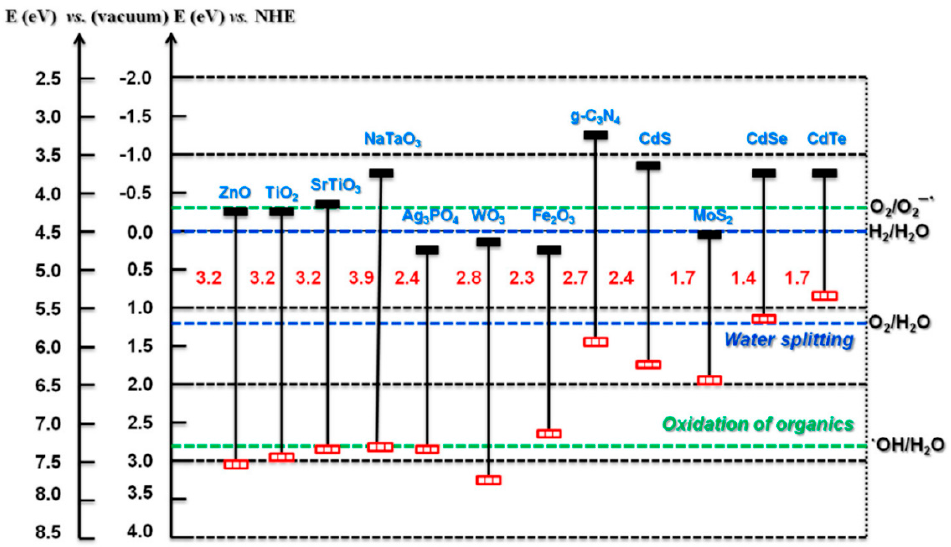
Figure 4. Bandgap and band edge potentials for different semiconductors. (Reproduced with permission from [37]: Kumar, S.; Karthikeyan, S.; Lee, A. g-C 3 N 4 -Based Nanomaterials for Visible Light-Driven Photocatalysis. Catalysts 2018 , 8 , 74, doi:10.3390/catal8020074. Copyright (2018), MDPI (Basel, Switzerland)).